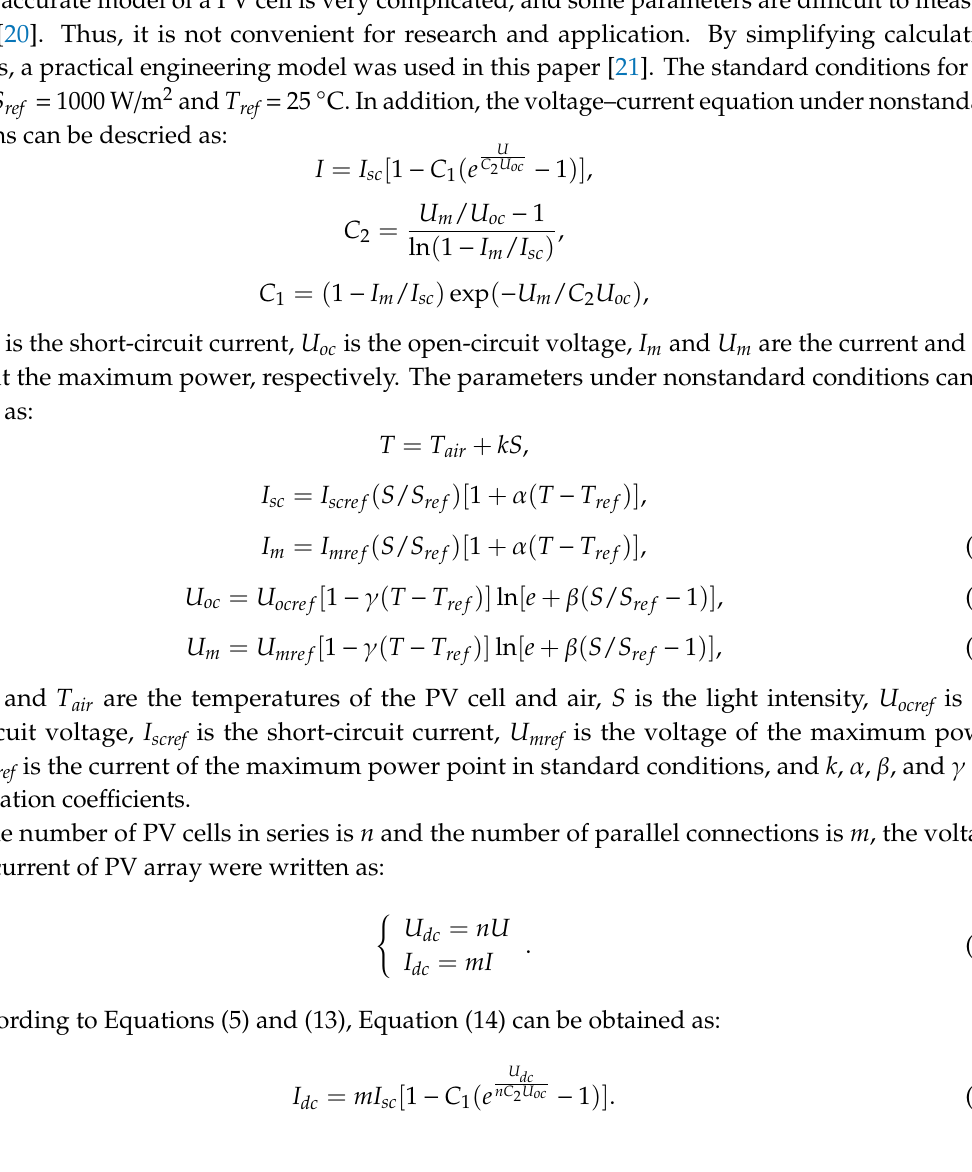
Figure 4. The structure of photovoltaic (PV) generation. Symbols: C dc , direct current (DC) capacitor; U dc , DC-side output voltage; i C , the current of a DC capacitor; V k , alternating current (AC)-side output voltage; L f , AC inductor; i g , AC-side output current; V g , the voltage of the point connected with a power system.